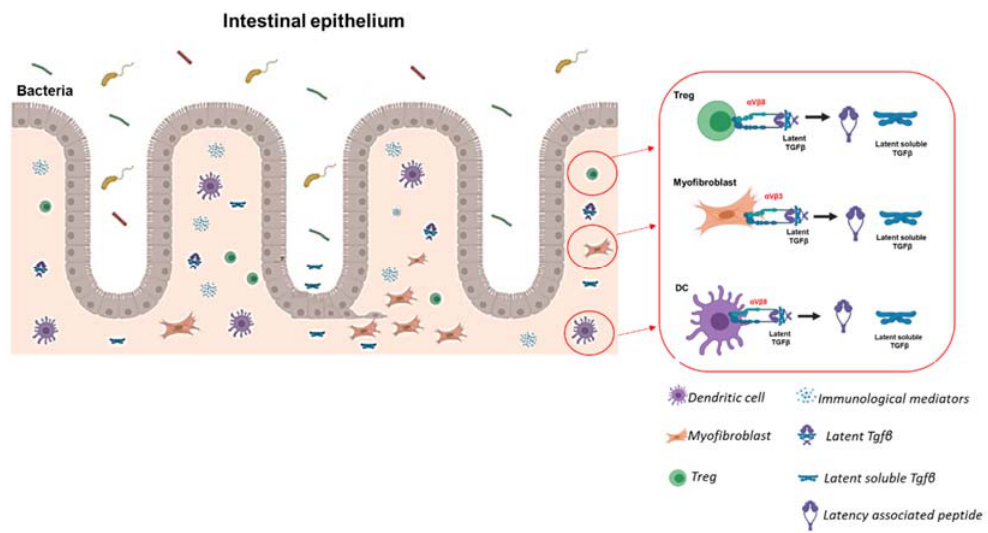
Figure 3. Latent and active TGF β in IBD . TGF- β production as a soluble ligand is sustained by immune cells (mainly dendritic cells (DCs) and regulatory T cells (Tregs)) and other cell compartments such as epithelial cells and fibroblasts. TGF- β is usually imprisoned in a latent form in the ECM by association with the latency-associated peptide (LAP). Following ECM remodeling, latent TGF- β is converted into the functionally active form by the action of α v β 3, α v β 6, and α v β 8 integrins. As a result, released TGF- β can bind to its receptors, usually residing on immune cells (T-cells, B-cells, DCs, and macrophages), epithelial cells, and fibroblasts.